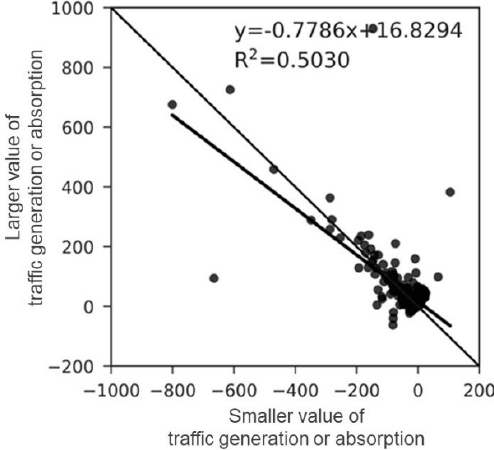
Figure 5. Comparison of the volume of traffic generation and absorption of both directions in the middle point. Diagonal line indicates y = − x.